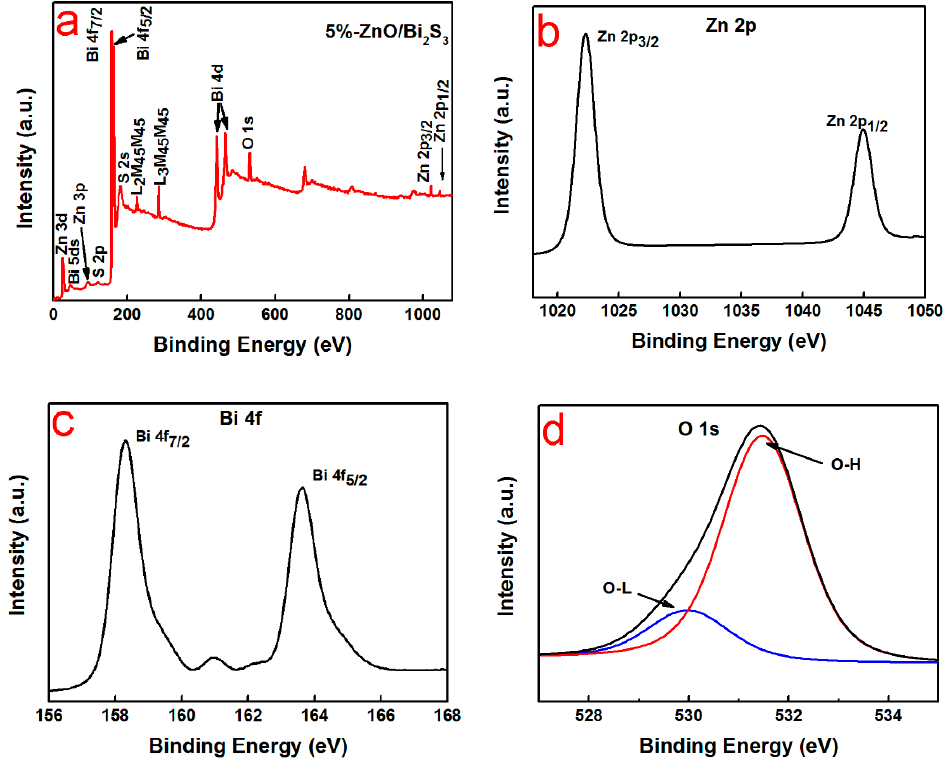
Figure 4. XPS spectra of 5%-ZnO/Bi 2 S 3 composite: ( a ) survey scan, ( b ) Zn 2p, ( c ) Bi 4f, and ( d ) O 1s.